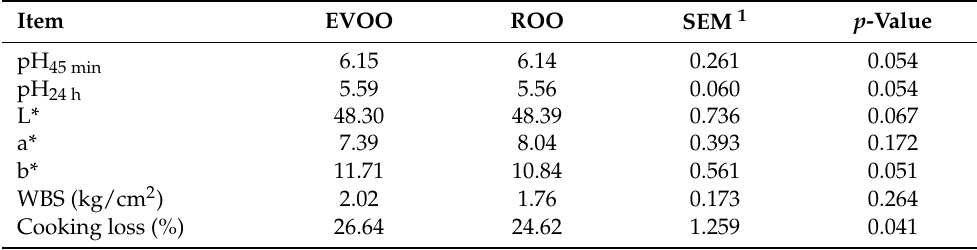
Table 2. Mean ( ± SE) physical and chemical characteristics of meat from the longissimus lumborum muscle of pigs fed a diet containing extra virgin olive oil (EVOO) or refined olive oil (ROO).